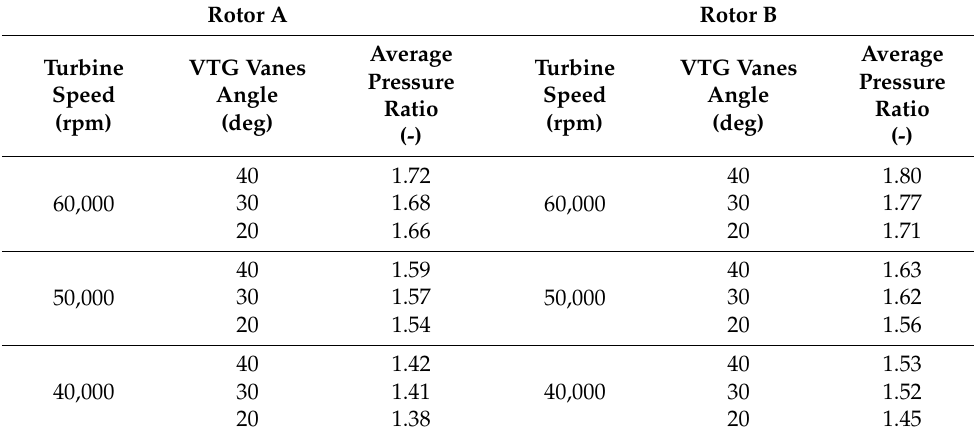
Table 8. The averaged values of the first-stage rotor PR during single revolution of the crankshaft for two rotor geometries, three VTG positions and three turbine speeds.